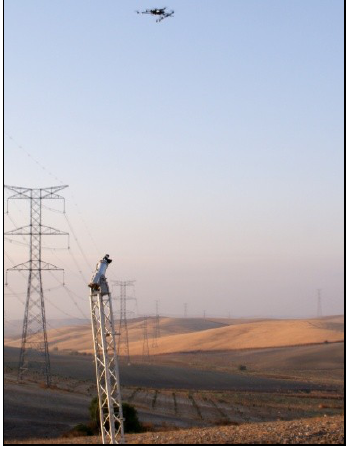
Figure 2. Photo of the applied TLS device and